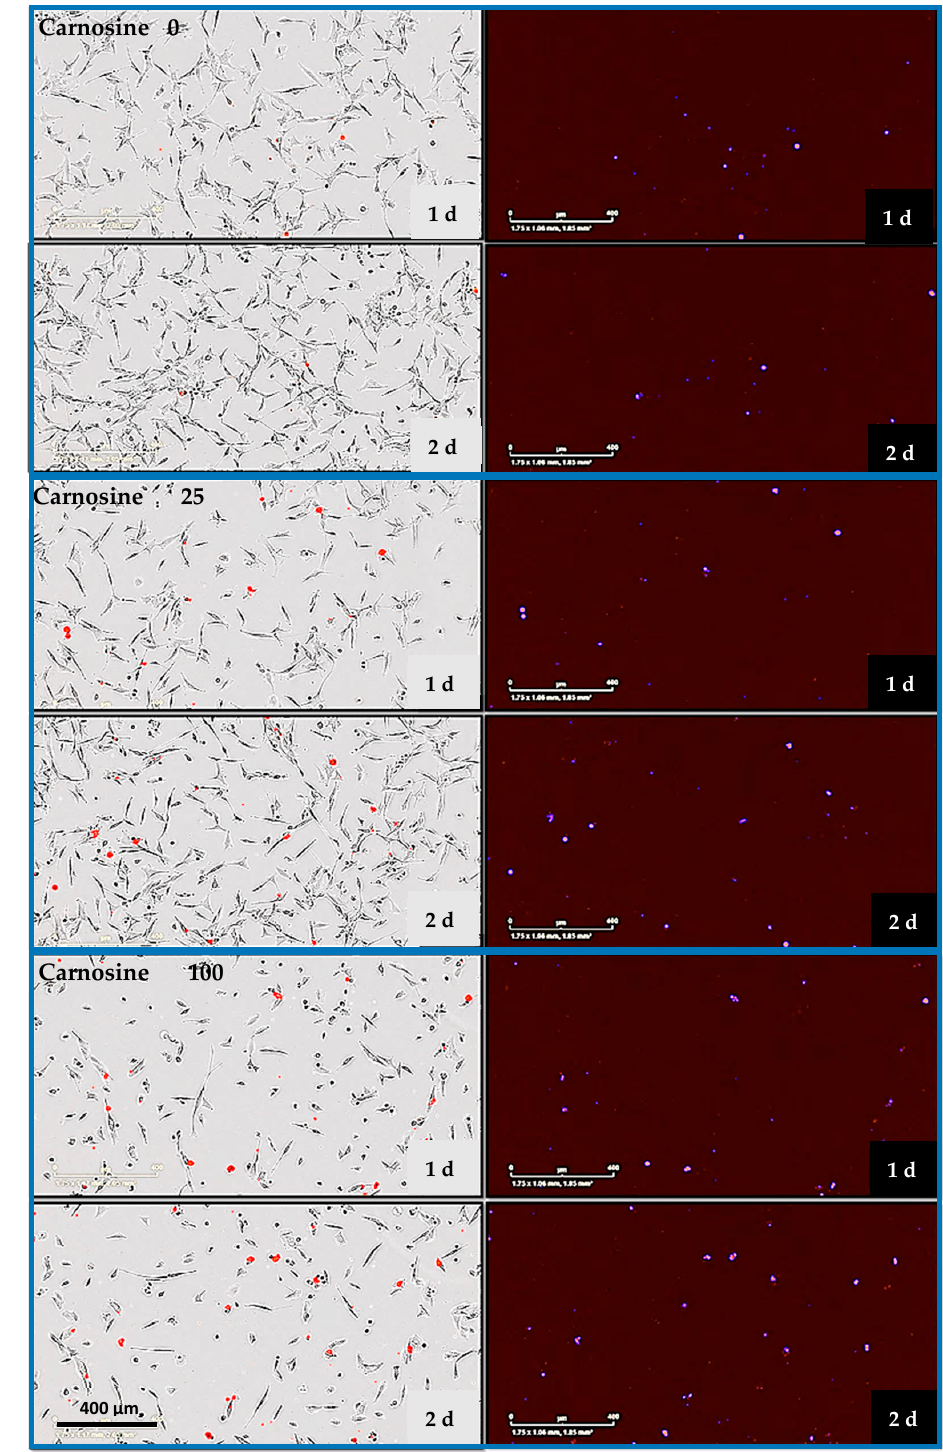
Figure 7. IncuCyte S3 live cell system (10×) images show cytotoxicity on U87 cells upon carnosine exposure after 24 and 48 h. Cells were treated with different carnosine concentrations in the presence of Cytotox Red dye (250 nM), which enters dead cells after losing the membrane and binds to the DNA to emit red fluorescence. Each photo was displayed as a phase and as a red channel with a blue mask. Scale bars are 400 µ